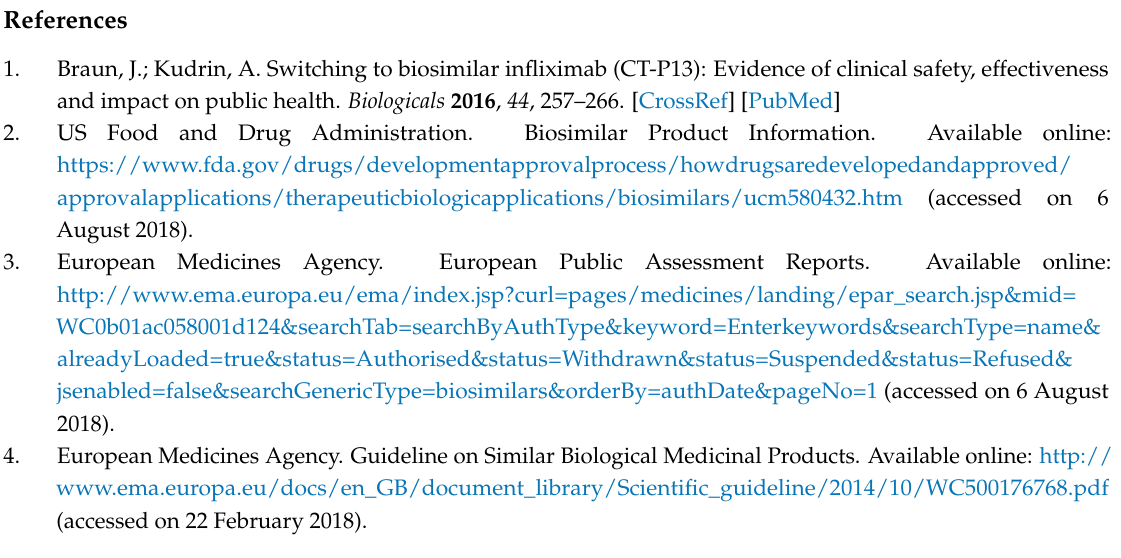
s1. Table S1: Biosimilars of biologics in rheumatology and oncology currently available in Russia. Survey Questionnaire 1: English language version of physician survey on biosimilars in Russia. Survey Questionnaire 2: Russian language translation of physician survey on biosimilars in Russia. Figure S1: Prescribing of biologic S2: Physician knowledge related to approval pathways and related regulatory issues for biosimilars in Russia. Figure S3: Need for education on biosimilars ( n =